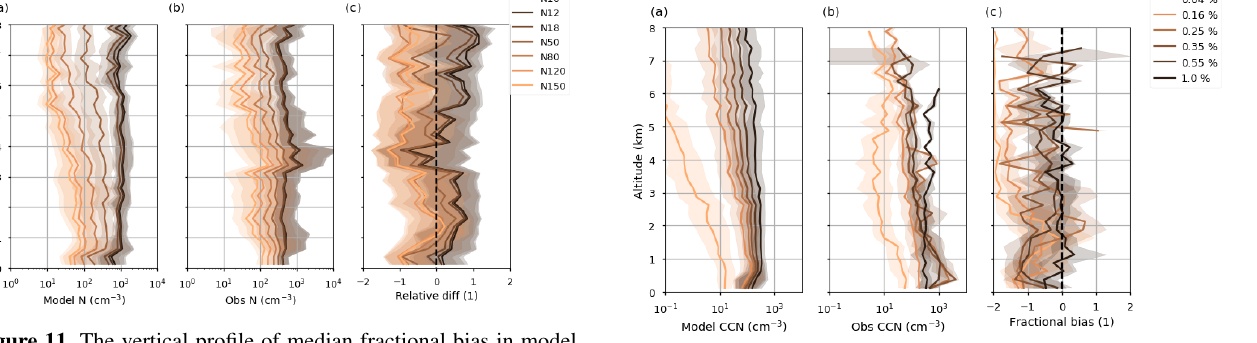
Figure 12. The vertical profile of median collocated model (a) , ob- served (b) and fractional bias (c) in CCN at the measured supersat- uration, as shown in the